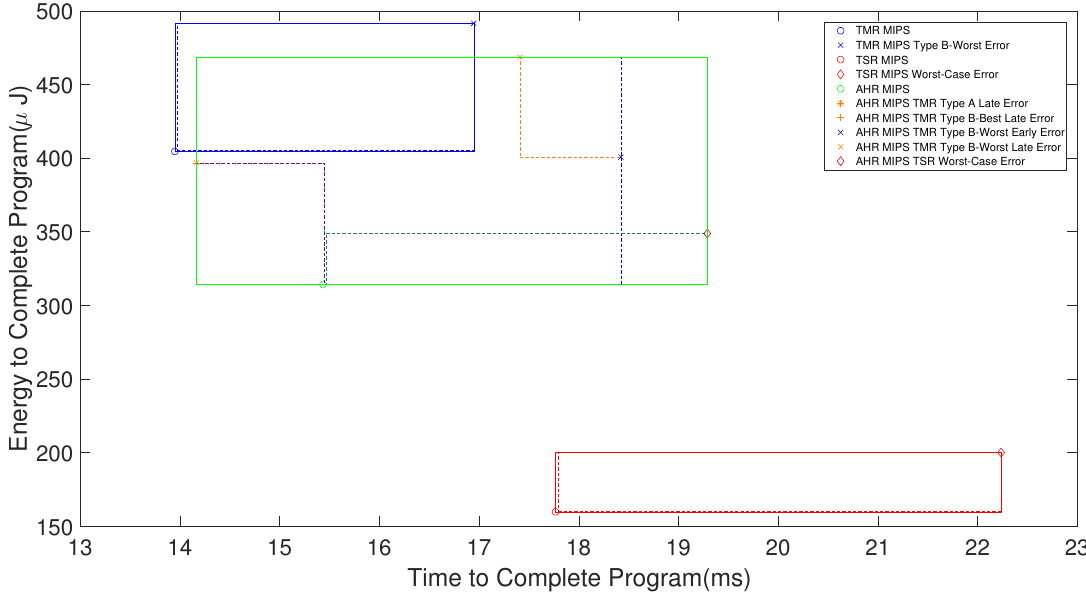
Figure 10. Average performance bounds for AHR MIPS with a TMR to TSR point at 30,000